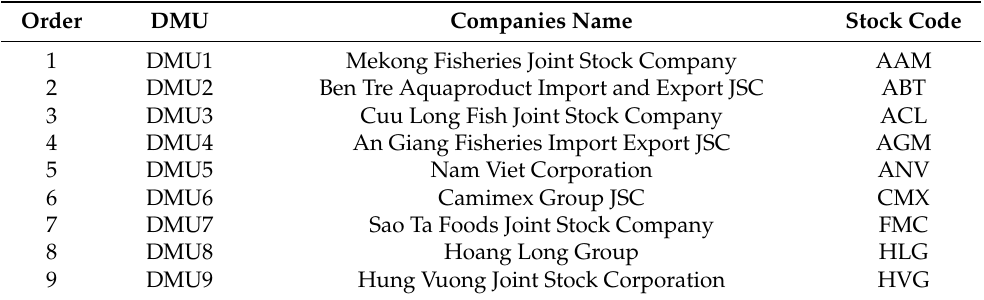
Table 2. List of fishery